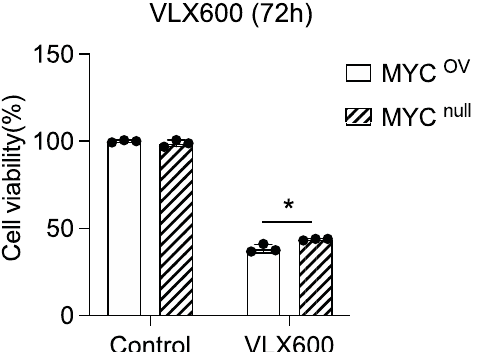
Figure 5. VLX600 induced a similar cytotoxicity in MYCN non-amplified neuroblastoma cells. ( A ) MYCN expression level in five neuroblastoma cell lines (Sk-N-AS, SH-SY5Y, CHP-212, Sk-N-BE(2) and IMR-32), Sk-N-AS and SH-SY5Y are MYCN non-amplified neuroblastoma cells; CHP-212, Sk-N-BE(2) and IMR-32 are MYCN-amplified neuroblastoma cells. ( B ) Dose-dependent response curve of Sk-N-AS, SH-SY5Y, CHP-212, Sk-N-BE(2) and IMR-32 to VLX600 for 72 h. ( C ) IC 50 calculated from ( B ) for five neuroblastoma cell lines. ( D ) Cell viability after 72 h VLX600 in cell lines including HO15.19 (a MYC null cell line, MYC null ) and HO-myc3 (a MYC overexpressed cell line, MYC OV ) which was as well used in our previous paper [35]. Data are shown as mean ± SD, statistical analysis using t -test. * p < 0.05.